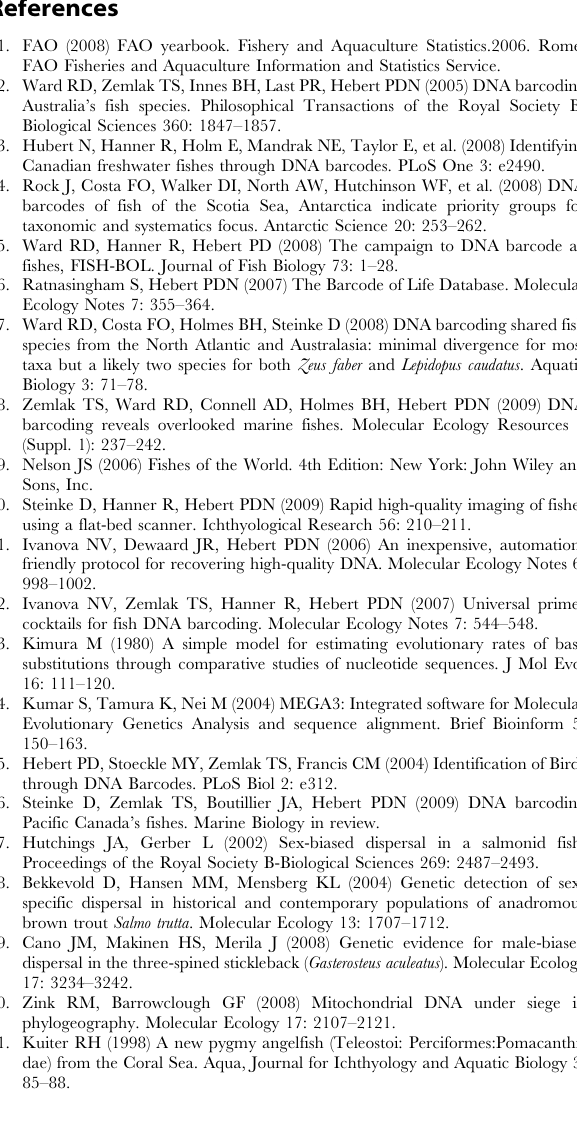
Figure S1 A neighbour-joining tree of COI sequence diver- gences (K2P) in all 1638 individuals of this study. Species